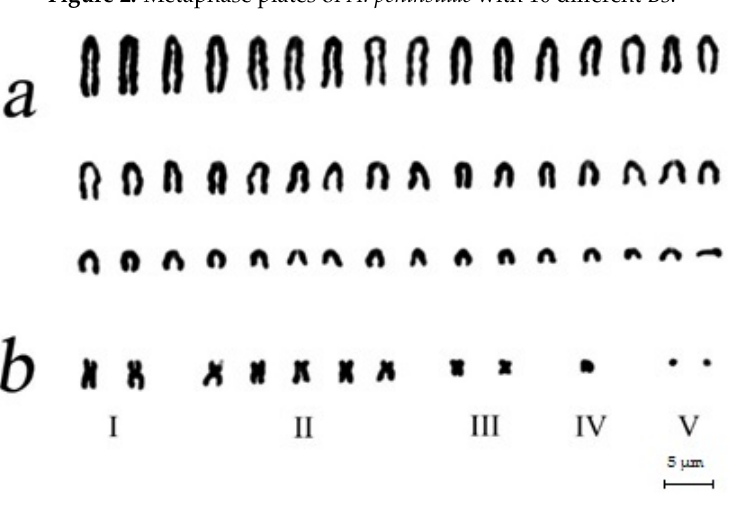
Figure 2. Metaphase plates of A. peninsulae with 10 different Bs.